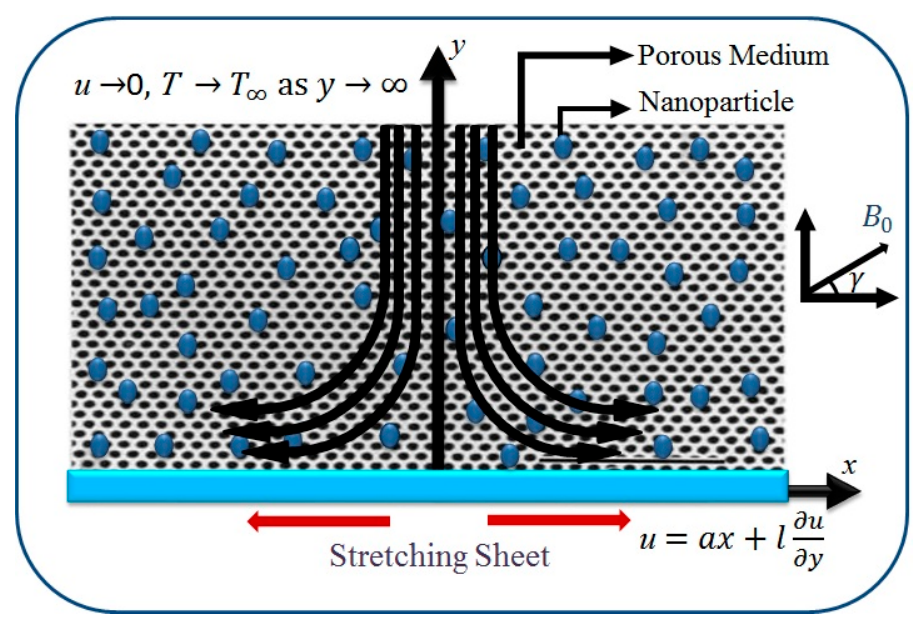
Figure 1. Physical view of the model.